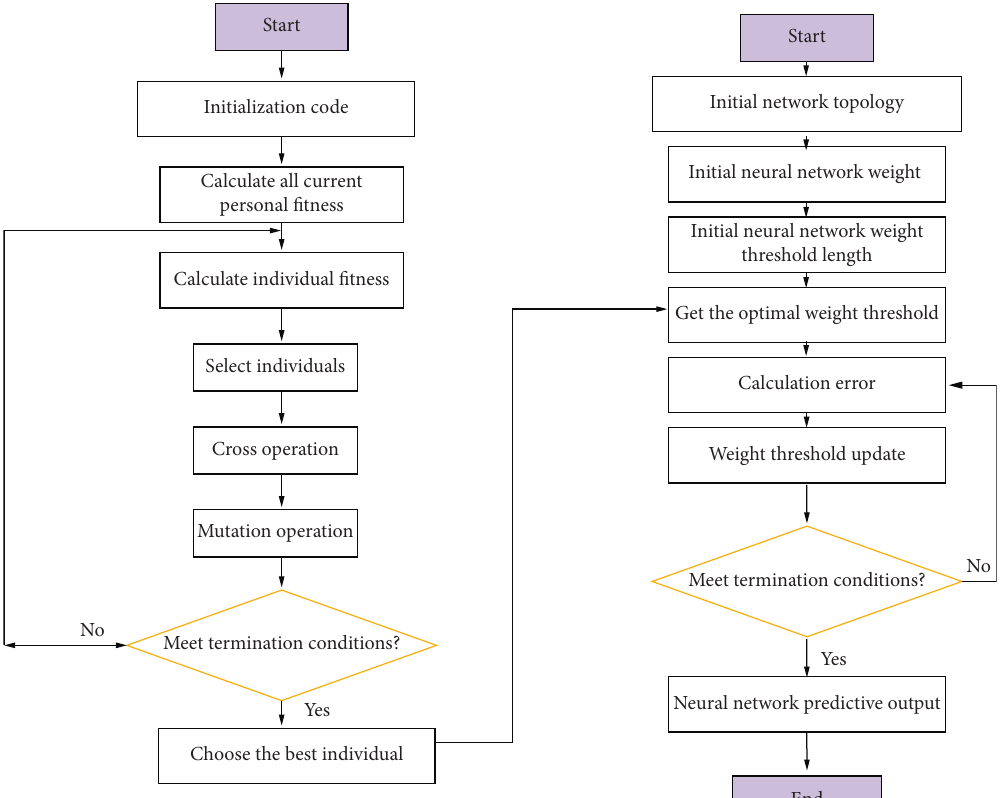
Figure 3: The flow chart of the neural network with the improved genetic algorithm.